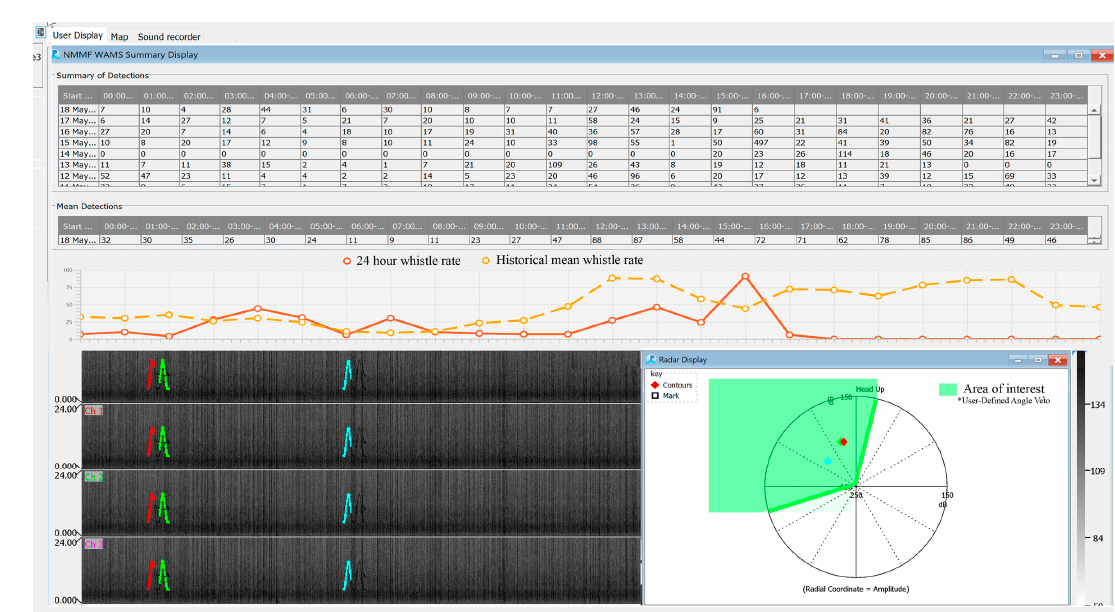
Figure 5. Interface of the WAMS module running in PAMGuard. The WAMS Summary Display on the top panel recordings the whistle detections in each hour of every day. The historical means are plotted below in orange (dashed) and the current 24-h detections are plotted in red (solid). In the lower left are the spectrograms of the four channels recording from the hydrophone array. The whistle detector detects and traces whistles (colored lines) and the corresponding colored diamonds on the radar display show the localization of the detection. An angle veto is used to only include detections from the direction highlighted in green in the radar display during daily operations.